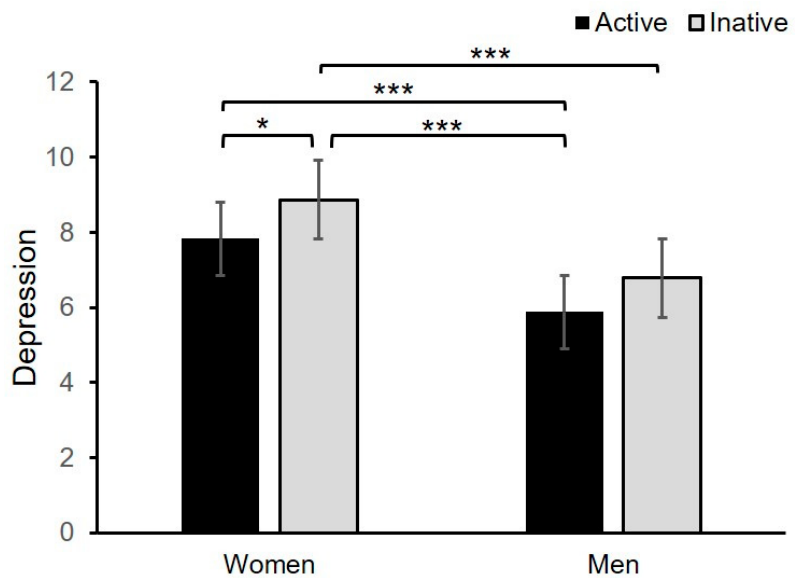
Figure 2. Mean depression scores for groups of undergraduates differing in sex (women, men) and engagement in physical activity (active, inactive). Error bars show standard errors. * p < 0.05, *** p < 0.001.